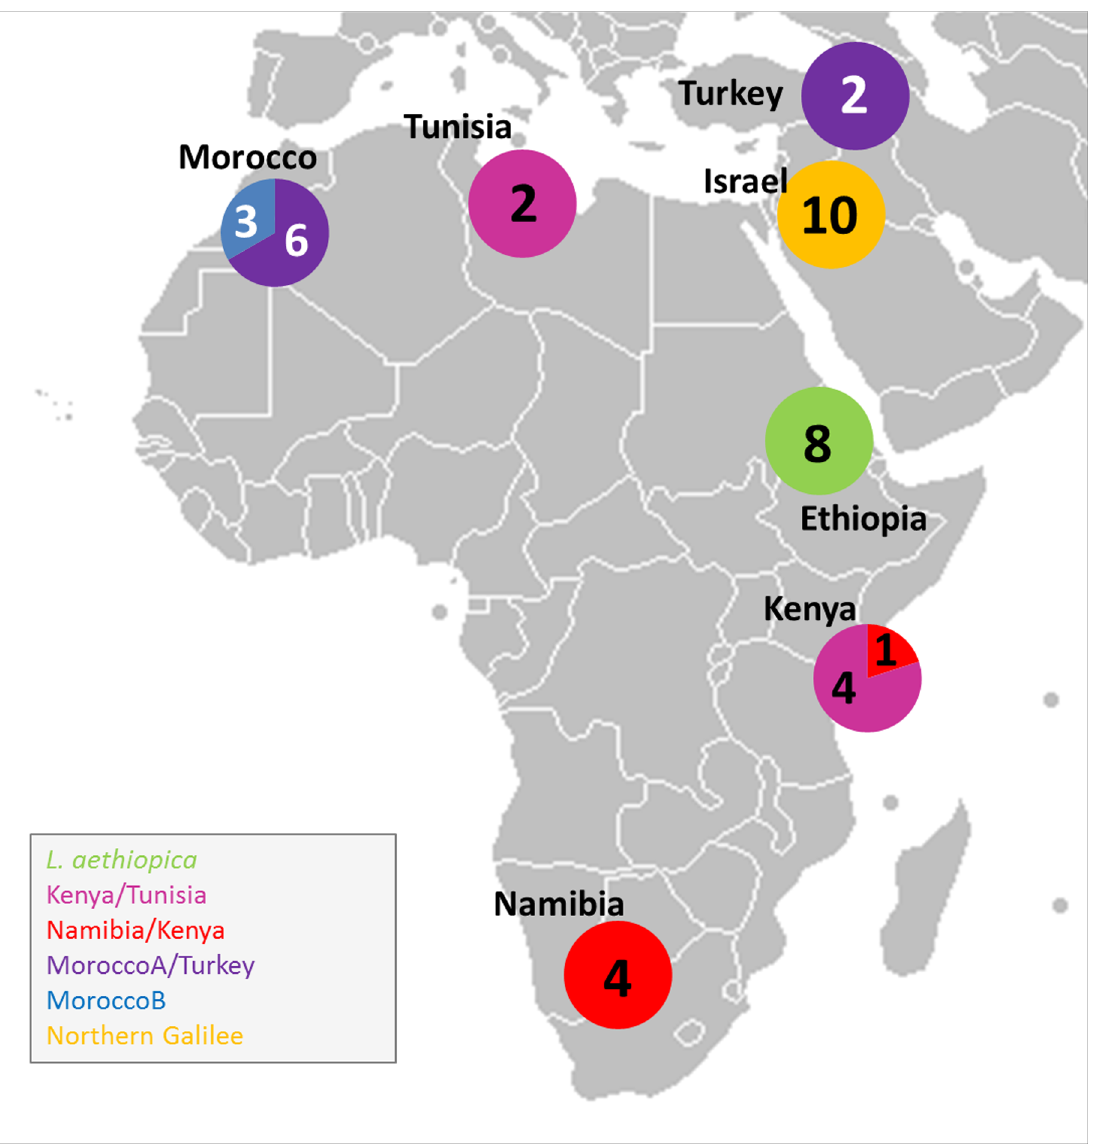
Fig 4. Map showing the geographical distribution of the six sub-populations in the main population Africa/Galilee. The six colours in the circles represent the six sub-populations where the colours correspond with those in Figs 1 – 3. The numbers in the circles indicate the number of strains of each sub- population from the country specified. Reprinted from and modified after http://commons.wikimedia.org/wiki/Maps_of_the_world#/media/File:BlankMap- World-v2.png under a CC BY